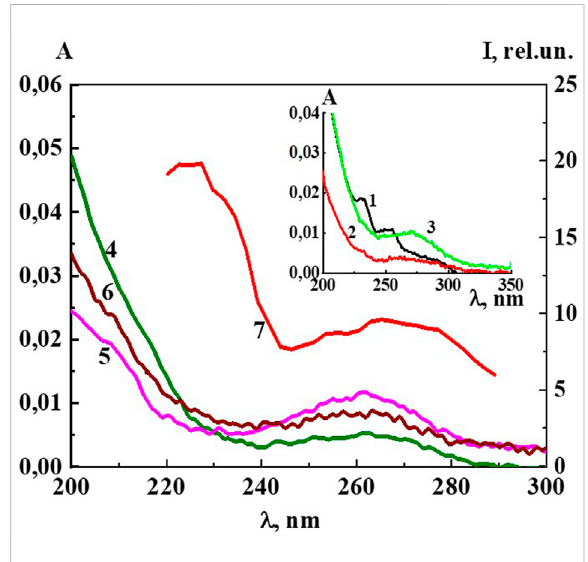
FIGURE 5 The absorption spectra of the Dox systems at 1) 1 · 10 − 6 M (Insert), 2) 1 · 10 − 7 M (Insert), 3) 1 · 10 − 8 M (Insert), 4) 1 · 10 − 13 M, 5) 1 · 10 − 16 M, 6) 1 · 10 − 19 M and 7) the excitation spectra ( λ em 340 nm) of the Dox system at1 · 10 − 16 M. Insert: The absorption spectra of the Dox systems at 1) 1 · 10 − 6 M, 2) 1 · 10 − 7 M, 3) 1 · 10 − 8 M. Measurements were performed at 25 ± 0.1 °